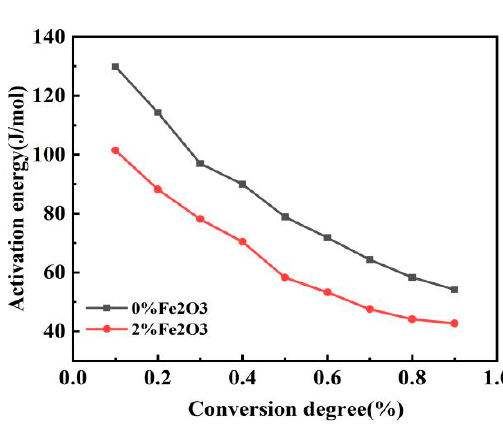
Figure 8. Graph of conversion